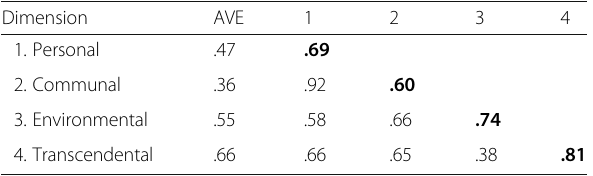
Table 3 Cronbach ’ s alpha and composite reliability coefficients for the original and shortened versions of the SWBQ b